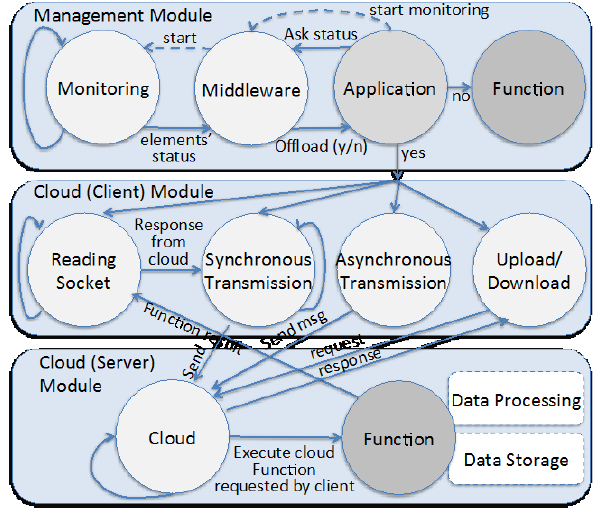
Figure 3. Management and Cloud state